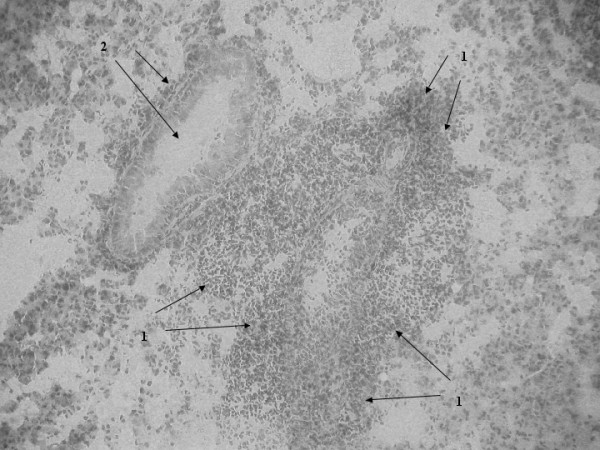
Light microscopy of lung tissue from mice infected with 106CFU of S. pneumoniae. SP-D-/- 24 h post-infection (figure 5), SP-D+/+ 24 h post-infection (figure 6), SP-D-/- 48 h post-infection (figure 7) and SP-D+/+ 48 h post-infection (figure 8). Magnification ×250 for figures 5 and 8, ×400 for figures 6 and 7. See results for description of arrows.